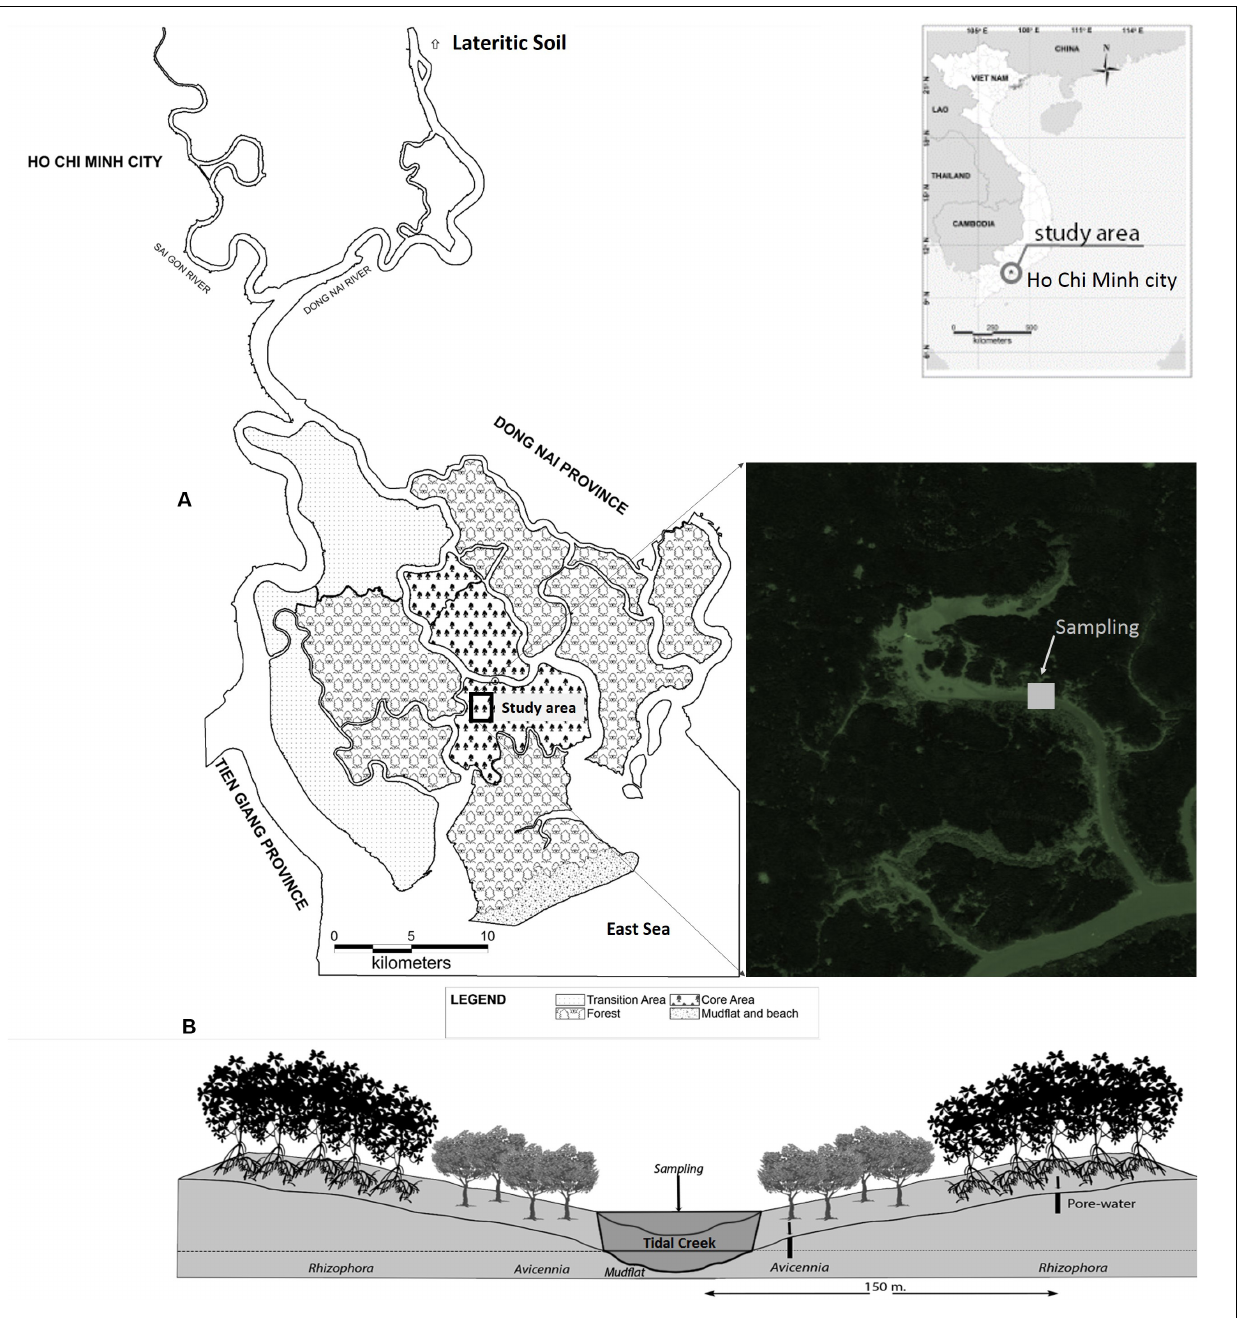
FIGURE 1 | Map of the study area showing: (A) the location of Can Gio mangrove in Vietnam and the location of the study site in Can Gio; and (B) the cross-section of the tidal creek without any direct fresh-water inputs except from rainwater.